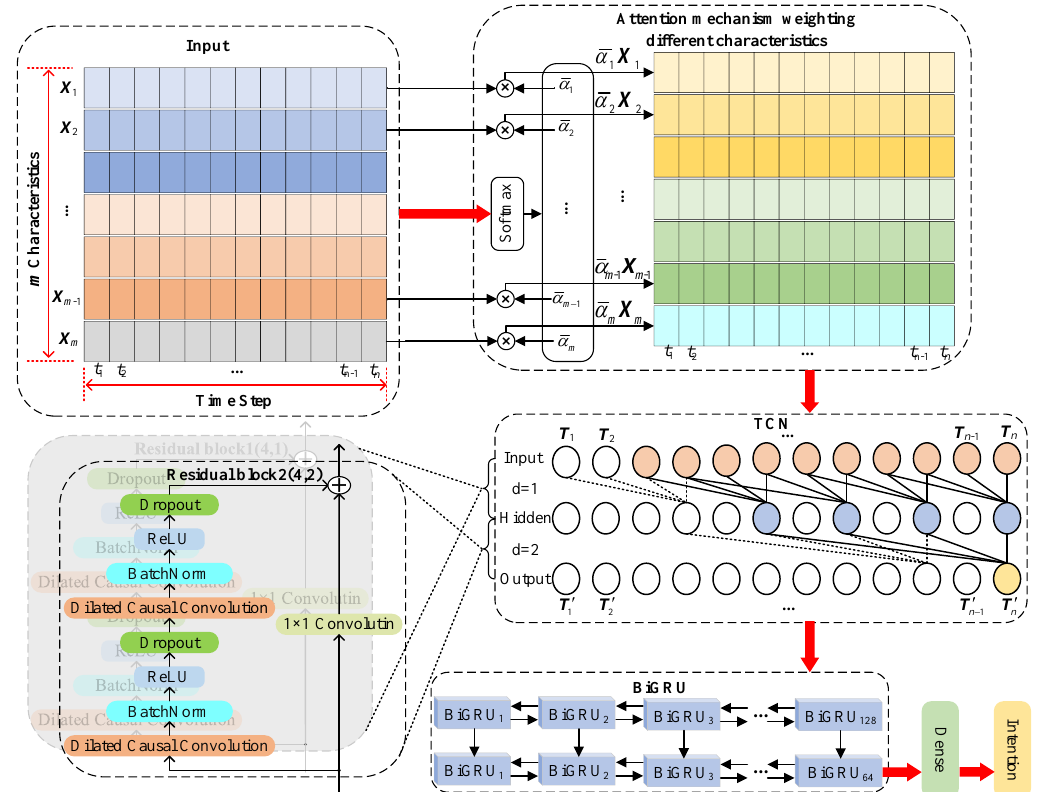
Figure 11. Proposed Attention-TCN-BiGRU framework.